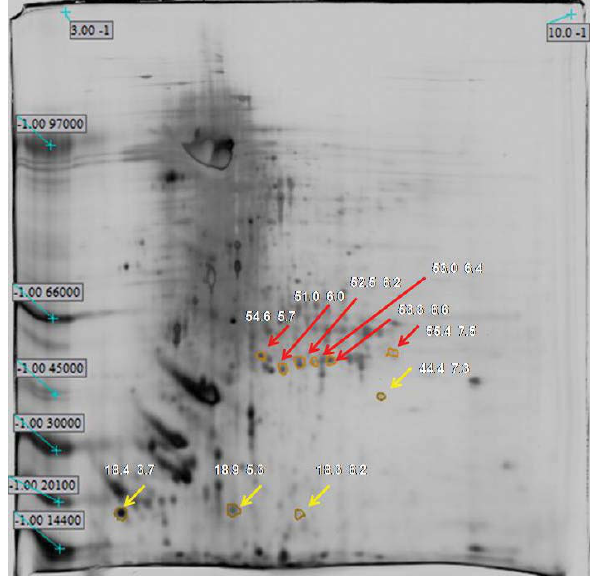
Figure 4 - Two dimensional gel electrophoresis of Leishmania amazonensis flagellar fraction. Proteomic analysis after visualization by silver staining. Imaging covering narrow range IPG strips of pH 3-10 - ob- served in the gel top. The standard of molecular mass range used is 14400 Da to 97000 Da; -1 is a software configuration parameter. Six (06) puta- tive spots for coronin are circled and indicated by a red arrow; four (04) Arp2/3 putative spots are circled and pointed by a yellow arrow. The mo- lecularweight(inKDa)andthecorrespondingisoeletricpointofeachpro- tein are shown in